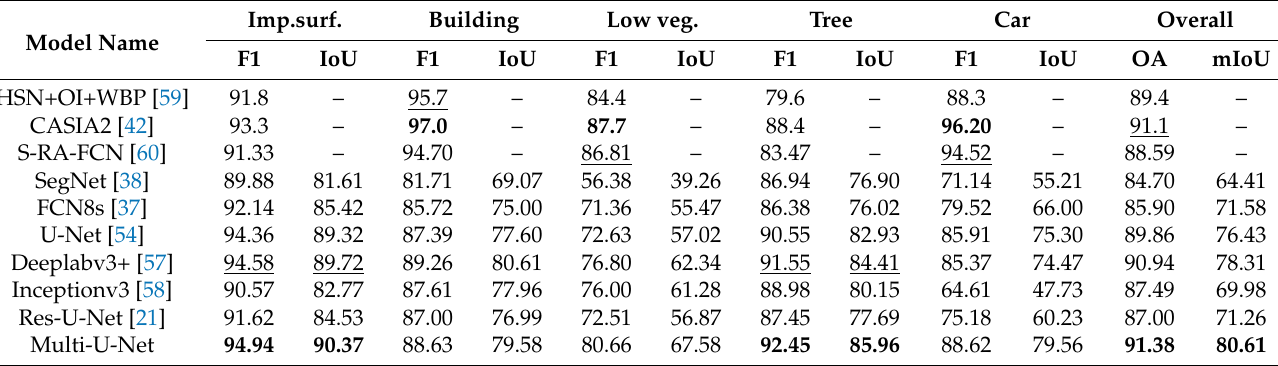
Table 2 lists the qualitative results of different methods in the Potsdam test data set. The OA and mIoU of Multi-U-Net are 91.38% and 80.61%, which are better than other algorithms. At the same time, Multi-U-Net has achieved the best accuracy on impervious surface and tree. CASIA2 has the best accuracy in building extraction and car, and the overall accuracy is second only to Multi-U-Net. Inceptionv3+ and Res-U-Net perform better on the Urumqi dataset, but the mIoU on the Potsdam dataset is only 69.98% and 71.26%, indicating that the classification robustness in different scenarios needs to be improved. Table 2. The quantitative results using the deep learning models on the Potsdam test data set. The bold values denote the best result, and the underlined values denote the second best result achieved by models. Imp.surf. Model Name